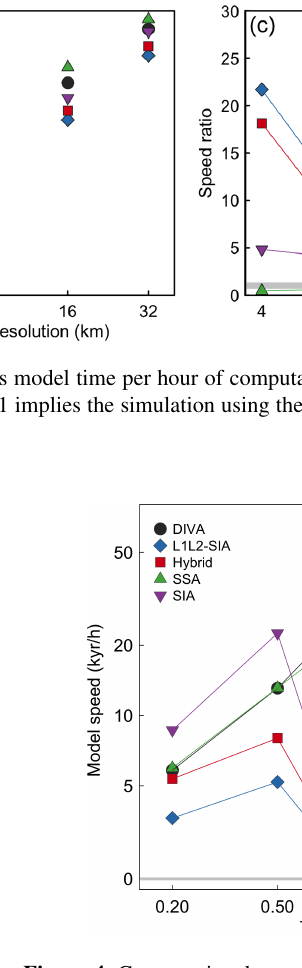
Figure 4. Computational speed (kiloyears model time per hour of computation on one processor) versus prescribed time step for sim- ulations of the GrIS at 16km resolution using the DIVA, L1L2-SIA, Hybrid, SSA and SIA solvers. Empty symbols at a speed of zero in- dicate simulations that have